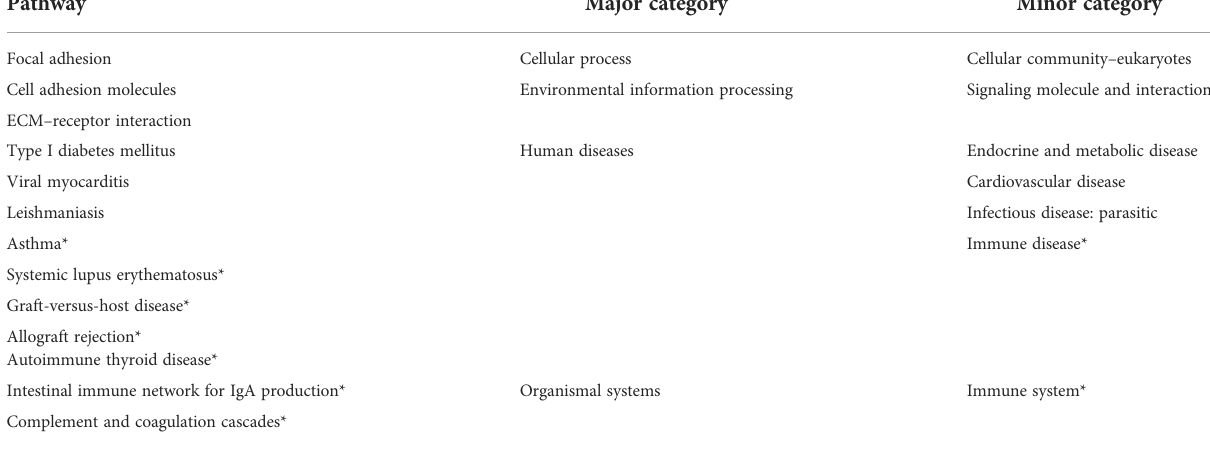
TABLE 2 Summary of 13 identical KEGG pathways from the intersection of the results of DEA, GSEA, and WGCNA.